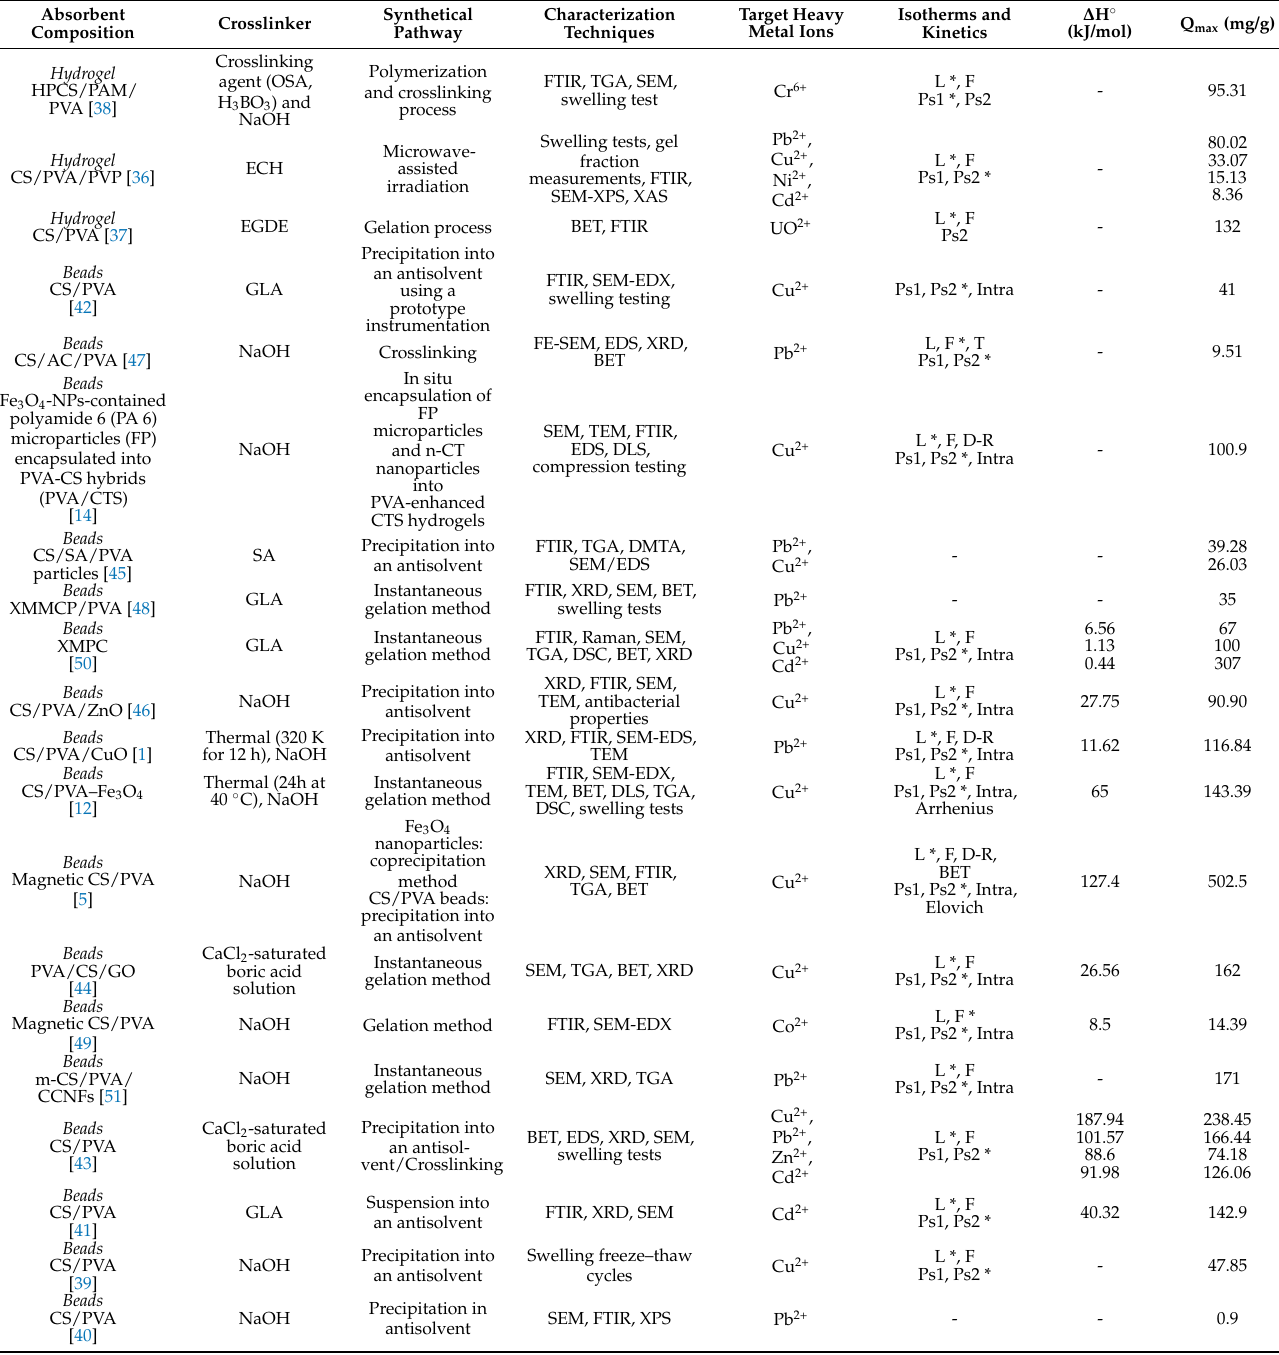
Table 3. Chitosan/poly(vinyl alcohol)-based hydrogels/beads for heavy metal ions